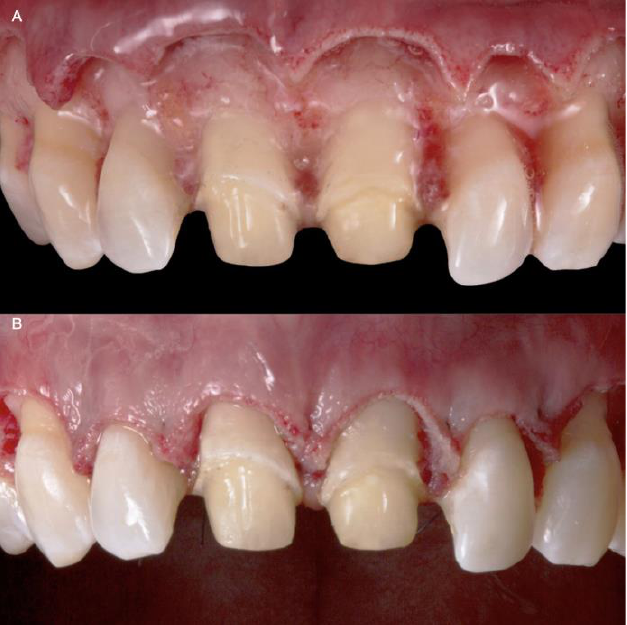
Figure 6. Flap release and reposition: ( A ) Flap release; ( B ) Flap reposition after suturing. After six months, veneer preparations were performed on lateral incisors to allow was made with polyvinyl siloxane impression material (Virtual 380, Ivoclar Vivadent, Schaan, Liechtenstein).